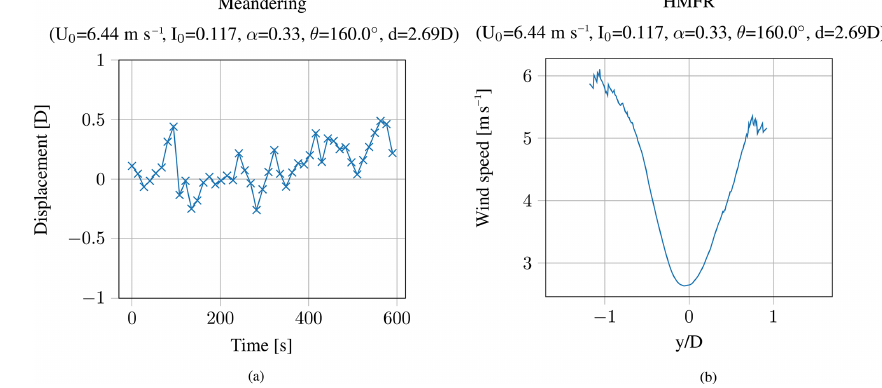
Figure 8. Meandering time series (a) and wind speed deficit in the HMFR (b) at 2 . 69 D downstream of the turbine.